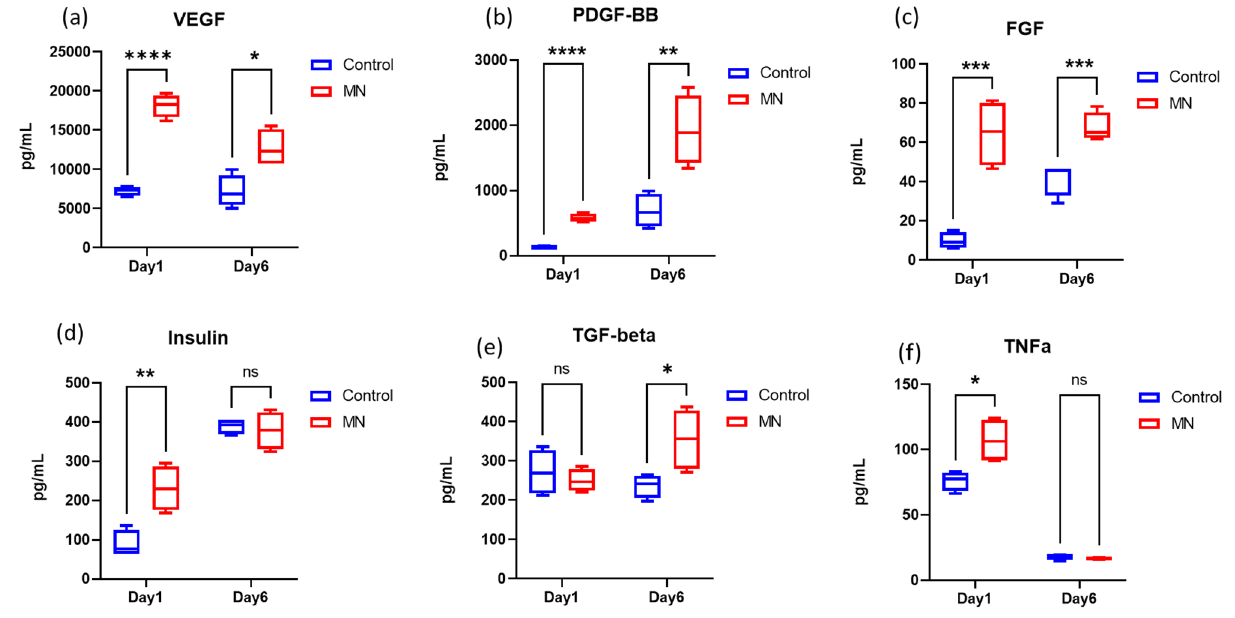
Figure 3. Quantification of growth factors in the ex vivo tissue. ( a – f ) The expression of growth factors was measured in pg/mL using a multiplex cytokine array. The medium was collected on Day 1 and Day 6 (N = 4, 2 biological samples per donor, 2 donors). Student t-test, * P ≤ 0.05, ** P ≤ 0.01, *** P ≤ 0.001, **** P ≤